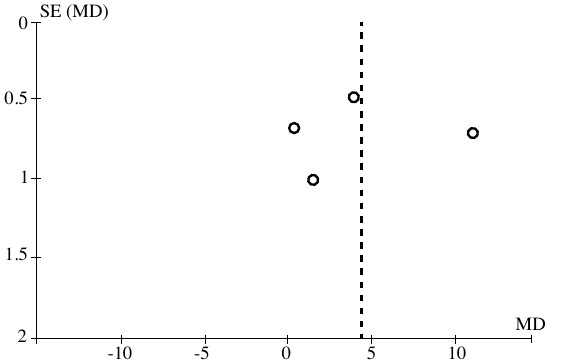
Figure 6. Funnel plot six results from the four selected studies for leg strength and muscular endurance measured through the “Sit and stand up” (repetitions) test from the Rikli Jones test battery The Egger test was performed with bias = 19,455,932 (95 % CI = 1.452238 to 37.459626) and P = 0.0399.